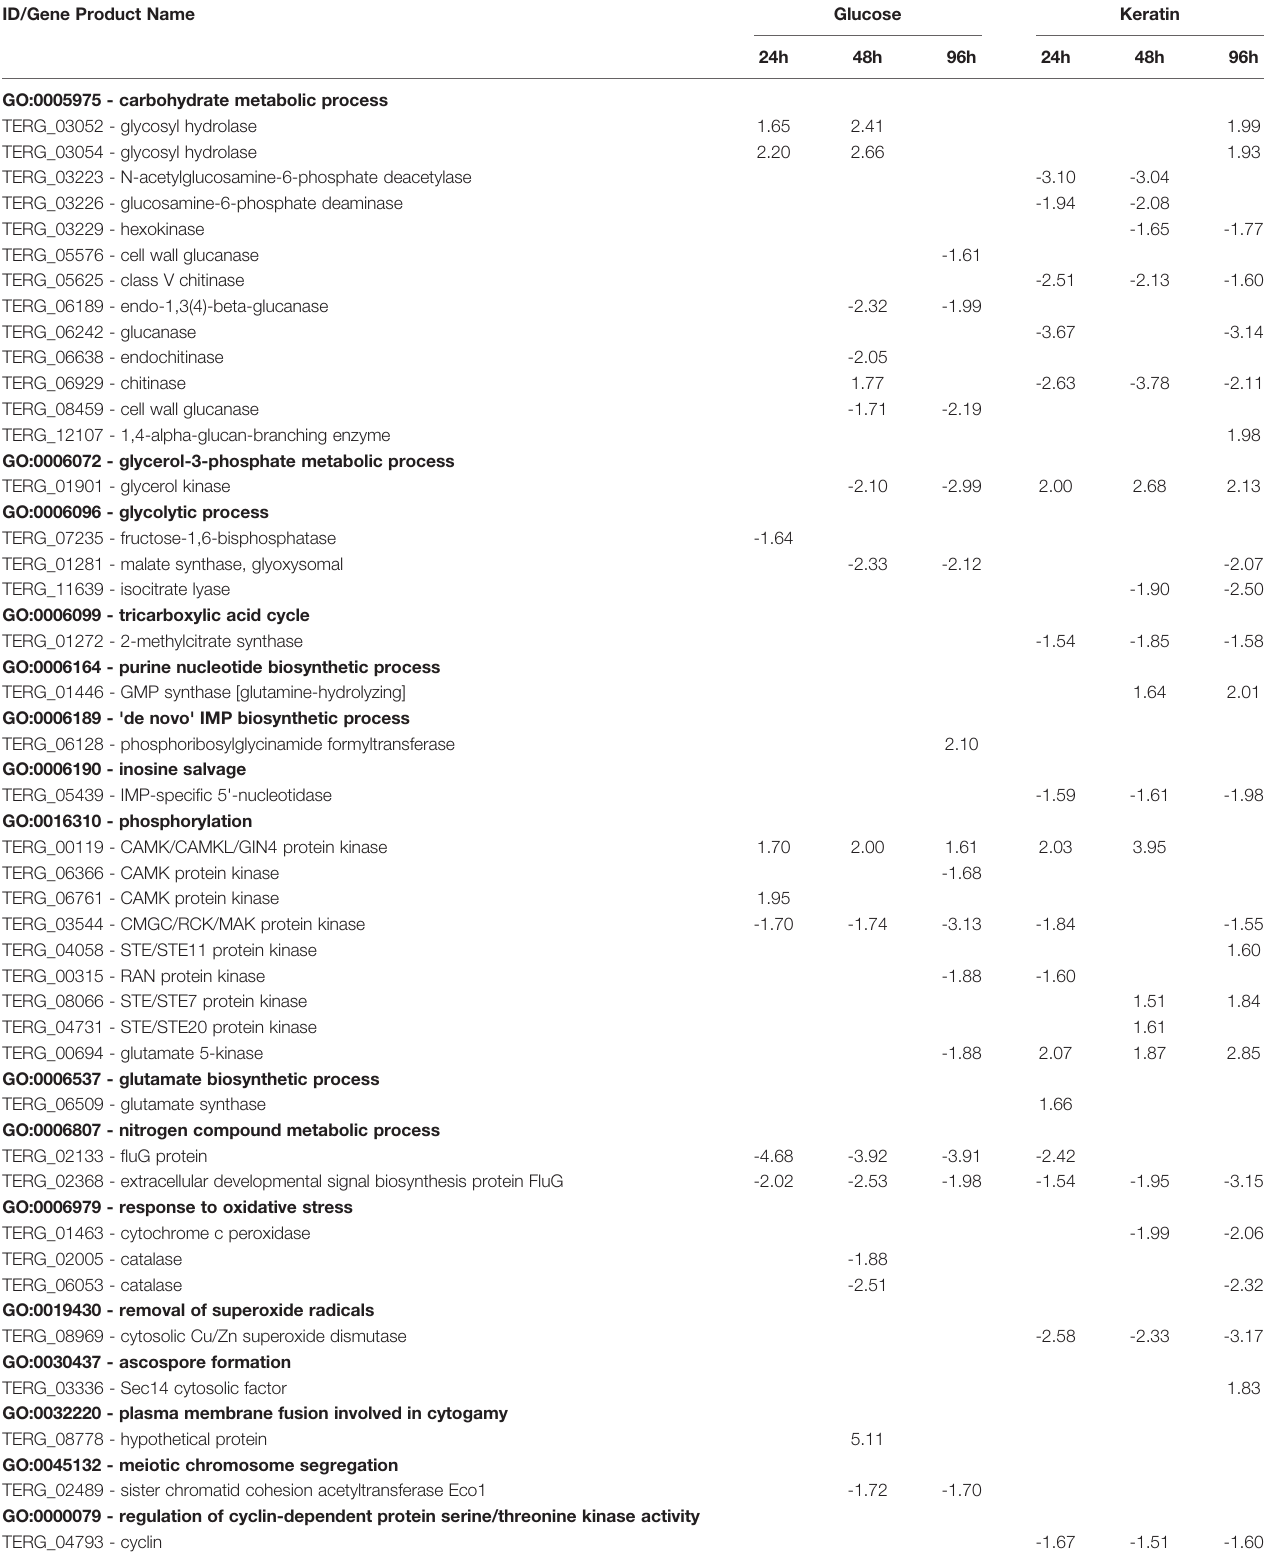
TABLE 1 | Differentially expressed genes belonging to some gene ontology terms – metabolism, oxidative stress response, phosphorylation,and reproduction – in D stuA mutant vs. wild ‐ type Trichophyton rubrum. ID/Gene Product